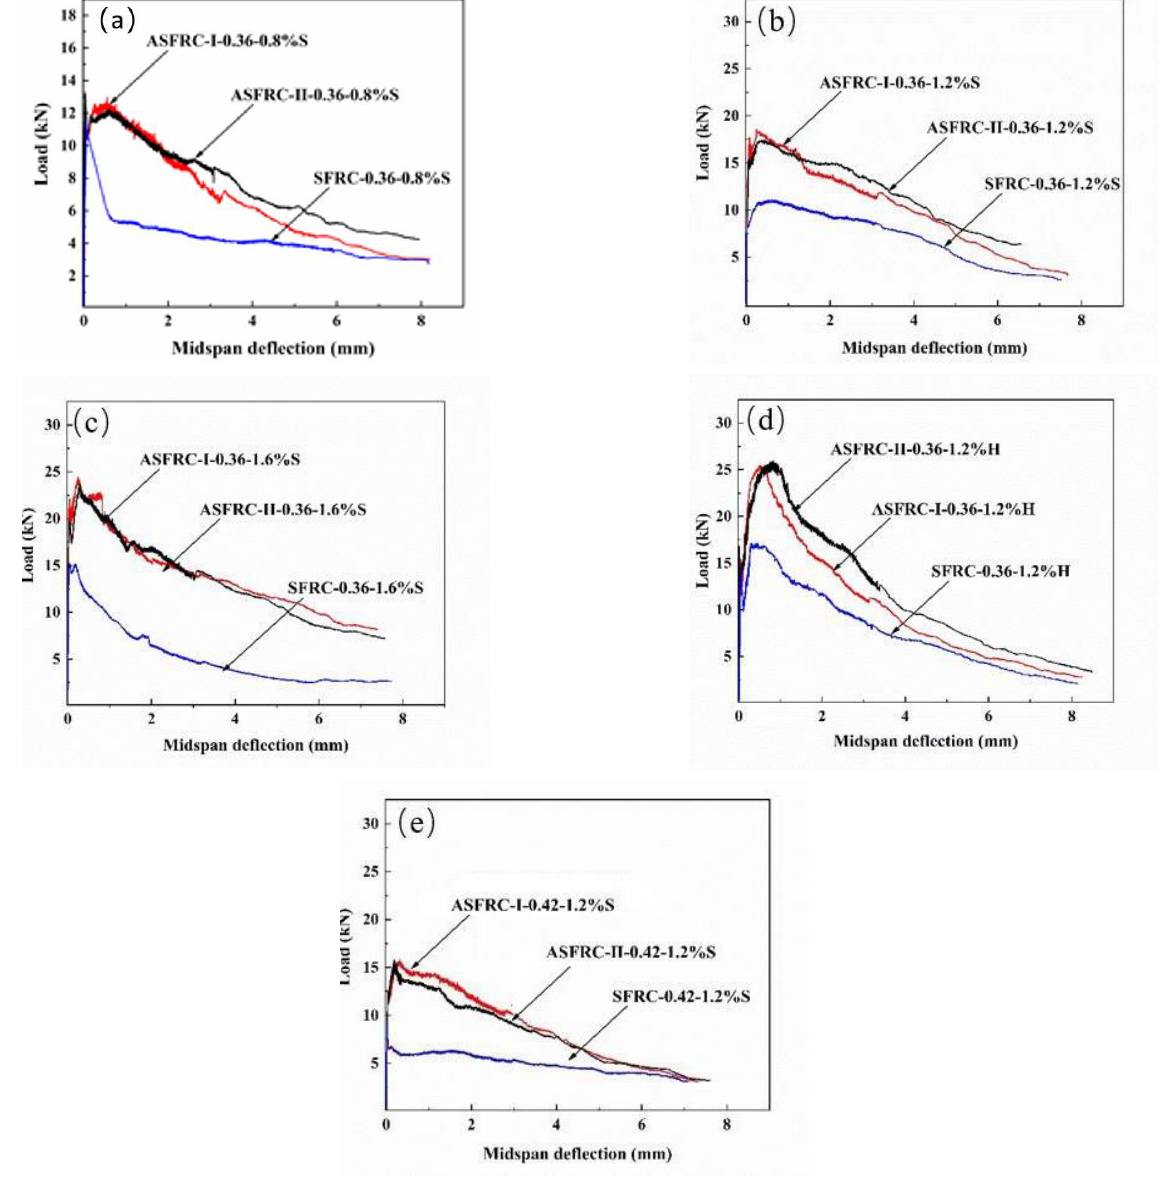
Figure 12. Load–span deflection curve. ( a ) W/C =0.36, V f = 0.8%, straight circular fiber; ( b ) W/C = 0.36, V f = 1.2%, straight circular fiber; ( c ) W/C = 0.36, V f = 1.6%, straight circular fiber; ( d ) W/C = 0.36, V f = 1.2%, hooked end fiber; ( e ) W/C = 0.42, V f = 1.2%, straight circular fiber.